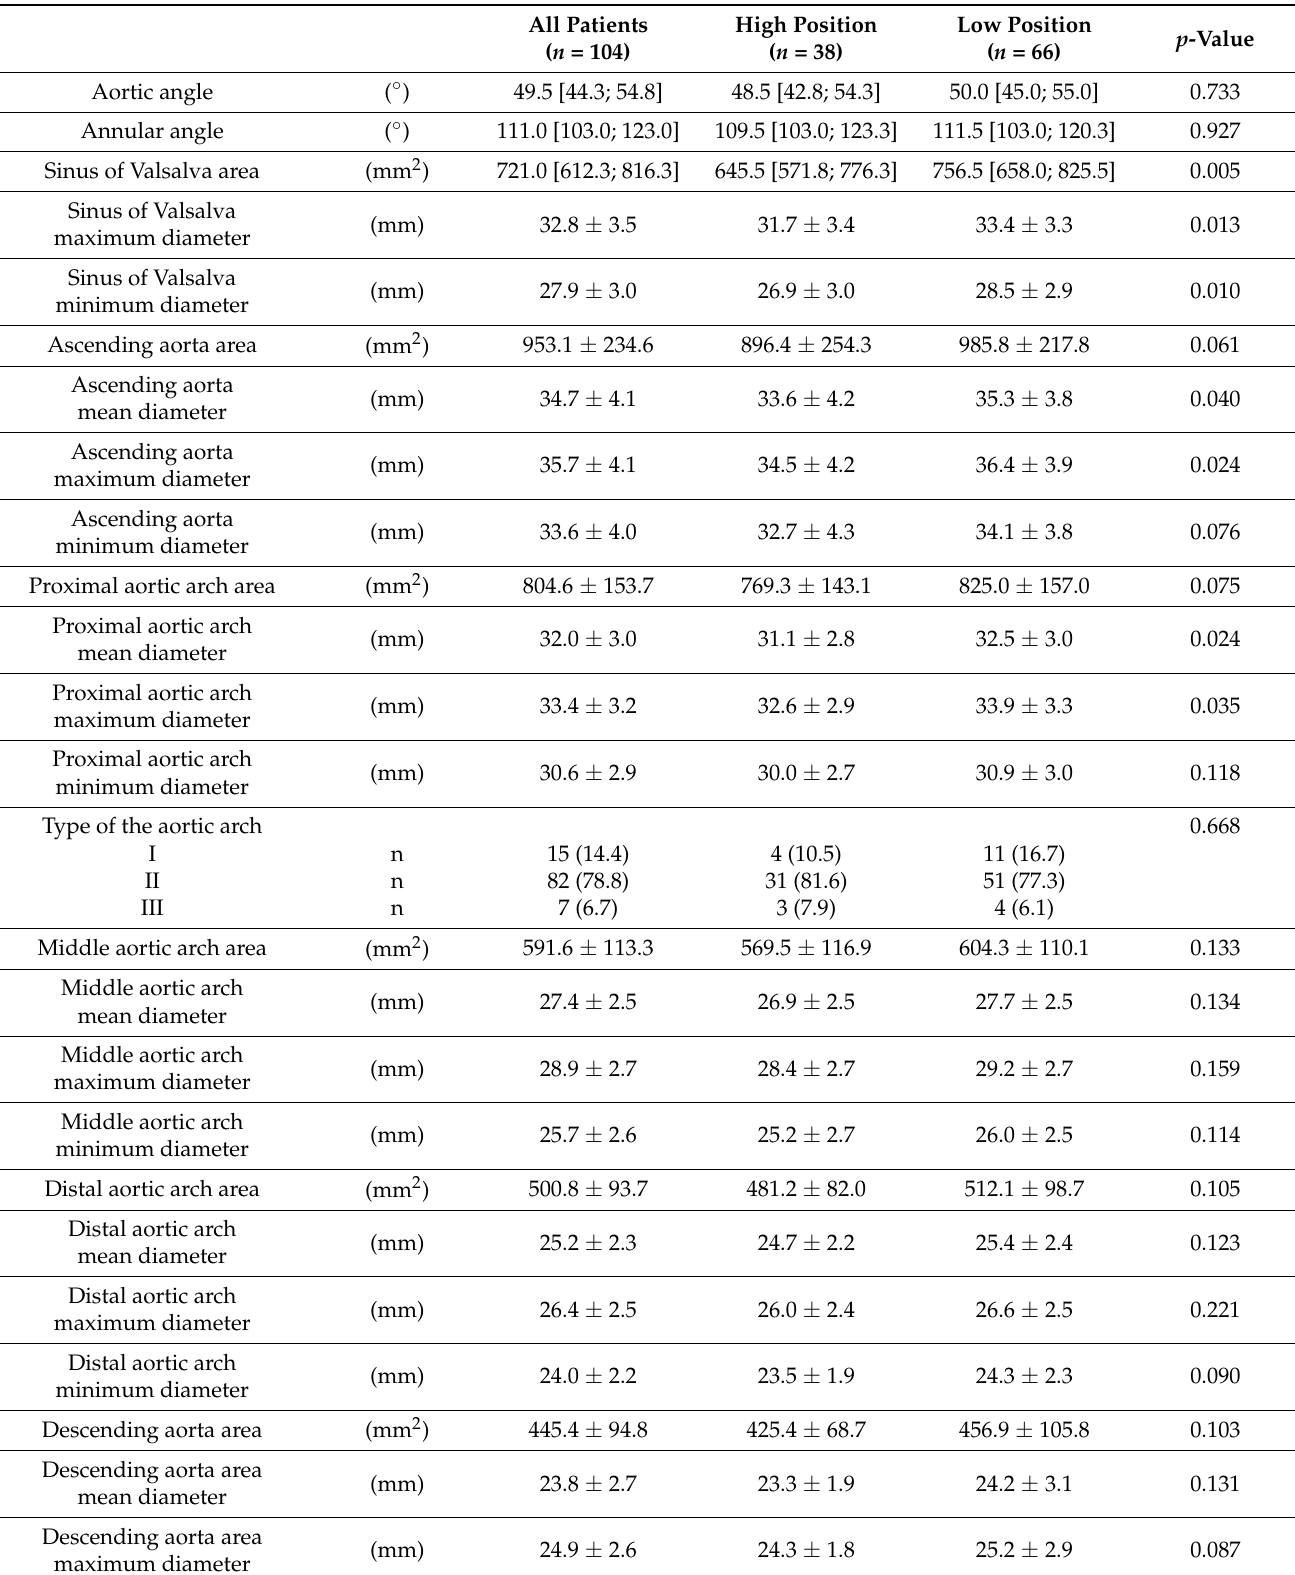
Table 2. Aortic geometry characteristics of the entire study population and in patients with a high and low THV